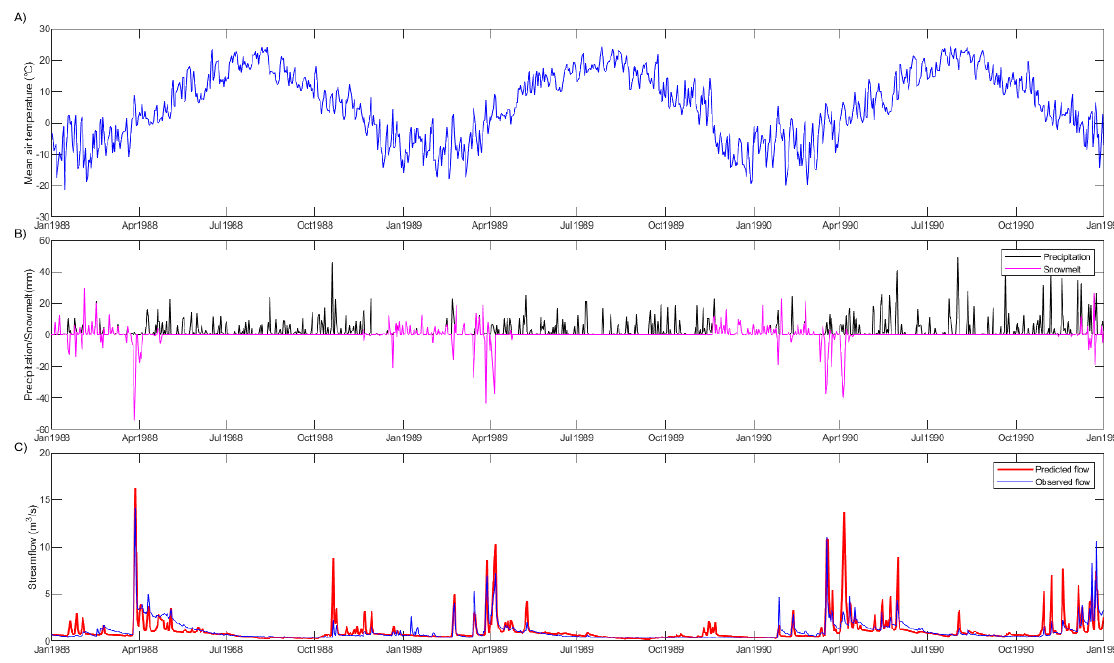
Figure 5. Observed mean air temperature ( A ), observed precipitation and simulated snowmelt over the contributing area ( B ), and simulated and observed flow at the hydrographic station for years 1988–1991 ( C ). Positive values for snowmelt indicate solid precipitation and negative values indicate snowpack melt.